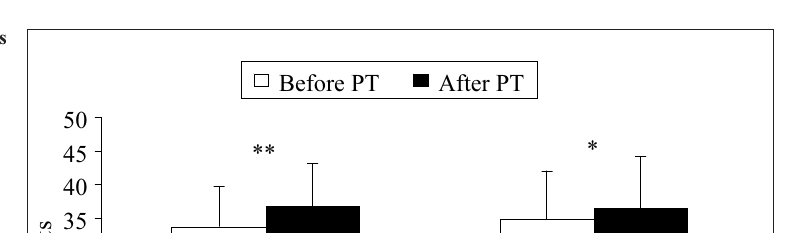
Figure 3. Changes in selective feet movement measurements in the control (C) and the test